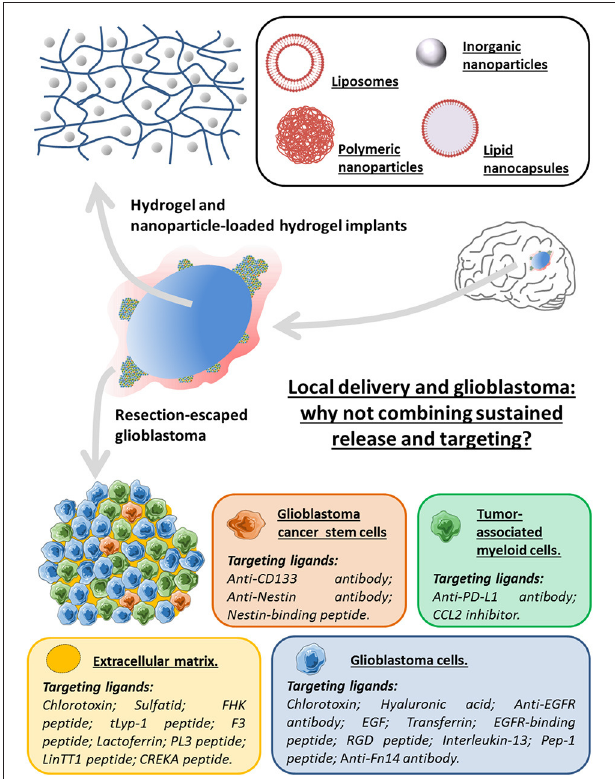
FIGURE 1 | Local delivery and glioblastoma: why not combining sustained release and targeting for the design of innovative therapeutic strategies using an implant-type approach. The synergy of the local strategy using hydrogels or nanoparticles (liposomes, lipid nanocapsules or inorganic and polymeric nanoparticles)-loaded hydrogels, with ligands specific to targets being overexpressed in various elements of the GBM microenvironment as a whole (glioblastoma cells, glioblastoma cancer stem cells, tumor-associated myeloid cells and extracellular matrix) may be of interest to alleviate some of the obstacles encountered in the treatment of